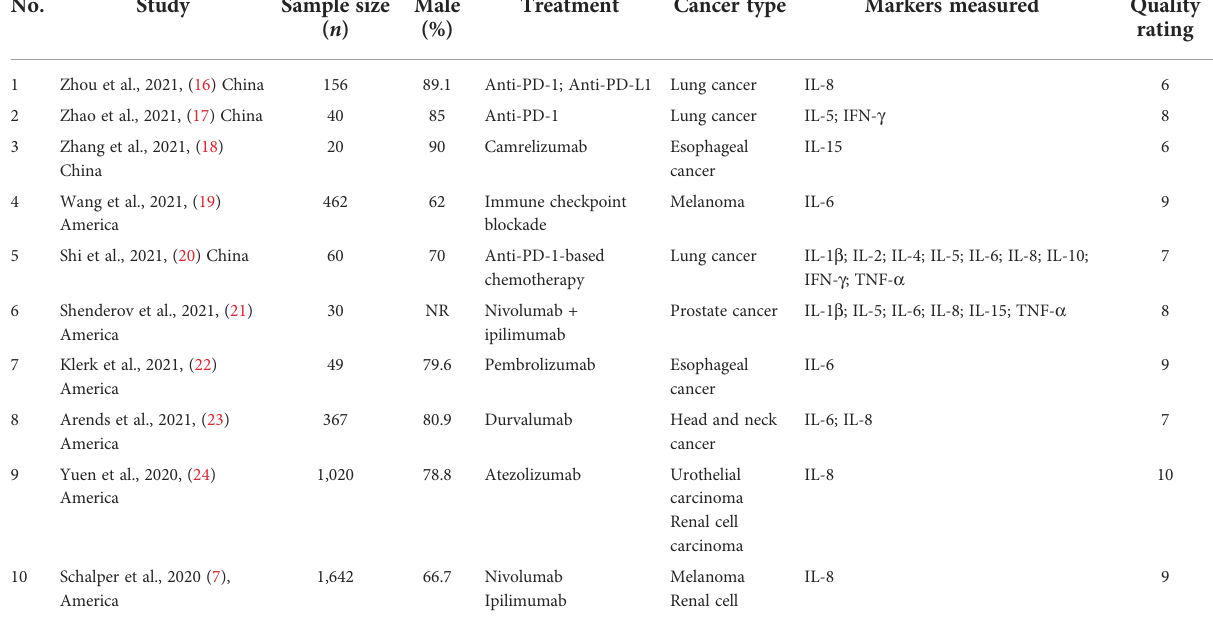
TABLE 1 Study characteristics and quality